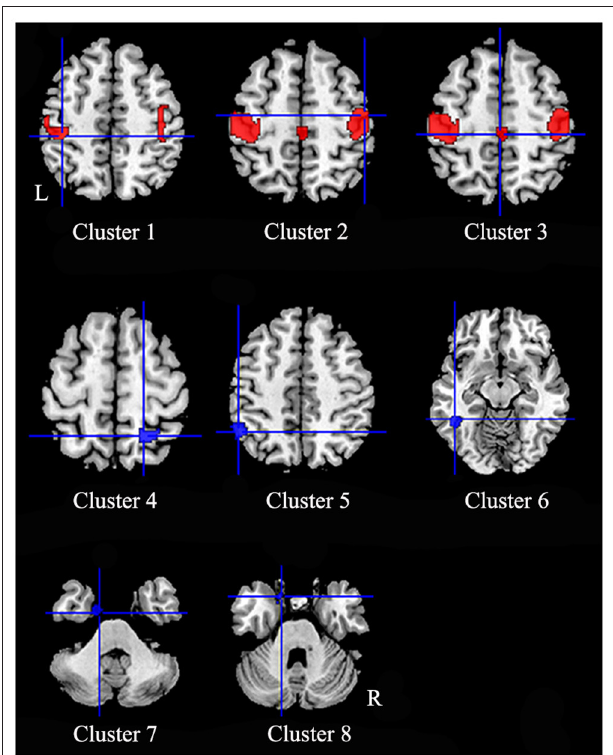
FIGURE 2 | Regions of gray matter structural alterations in patients with idiopathic blepharospasm compared with healthy controls. Compared to healthy controls, patients with iBSP showed increased GM in bilateral precentral and postcentral gyri (Clusters 1, 2), right supplementary motor area and bilateral paracentral lobules (Cluster 3), while decreased GM in right superior and inferior parietal gyri (Cluster 4), left inferior parietal gyrus (Cluster 5), left inferior temporal gyrus (Cluster 6), left fusiform gyrus (Cluster 7), and parahippocampal gyrus (Cluster